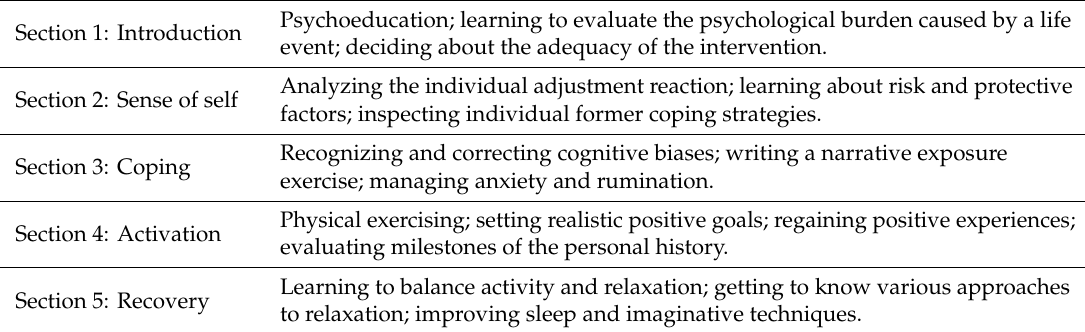
Table 1. Section